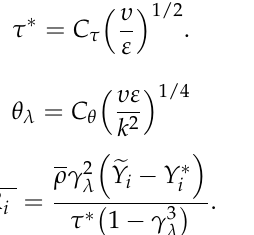
Figure 4. Comparison between experimental [23] and CFD values of vane efficiency at a plane located 10.16 mm downstream of the vane trailing edge.